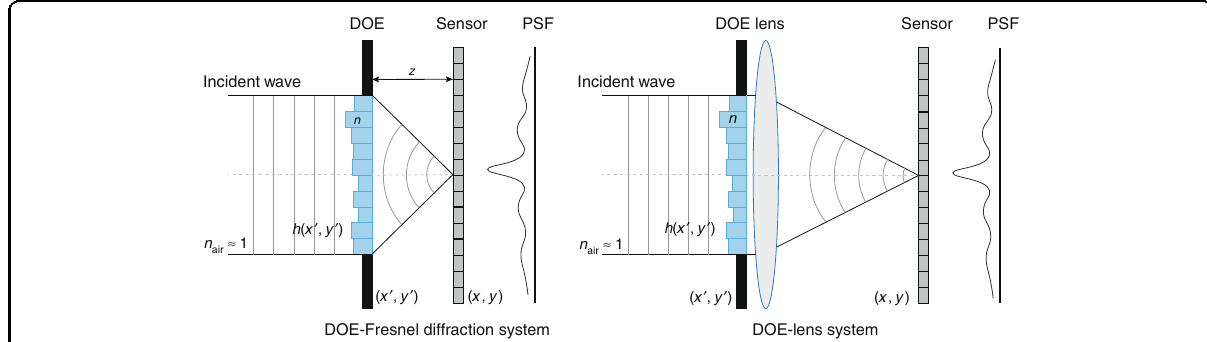
Fig. 6 Schematic diagram of diffractive spectral imaging via a diffractive optical element (DOE). The left is the system using a transmissive DOE and a sensor, where the incident wave passes a DOE and then propagates a distance z before hitting the sensor. The propagation can be modeled by Fresnel diffraction. The right system uses an imaging lens just behind the DOE. After passing the DOE, the incident wave converged on the sensor through the lens. DOE has a height pro fi le that introduces the phase